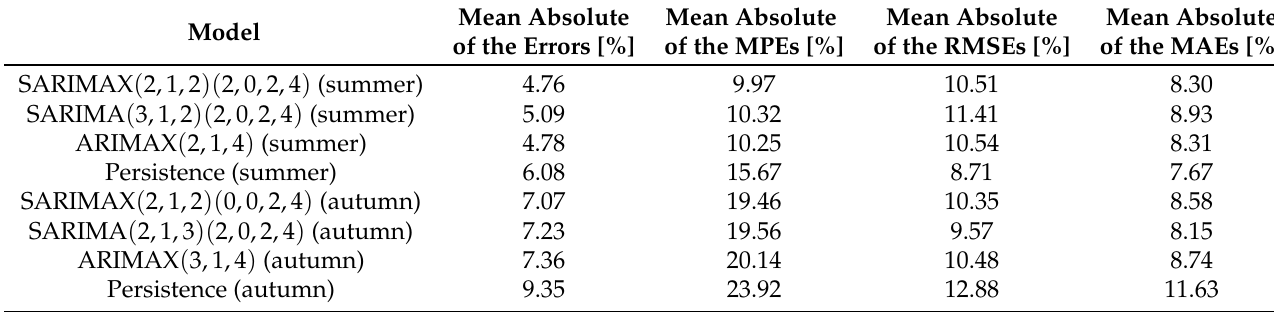
Table 6. Comparison between ARIMA-based and persistence models for the case of two different seasons of the year, and reporting the results of the inter-day scenario. The choice of the seasons is based on almost static (summer) vs. fluctuating (autumn) weather